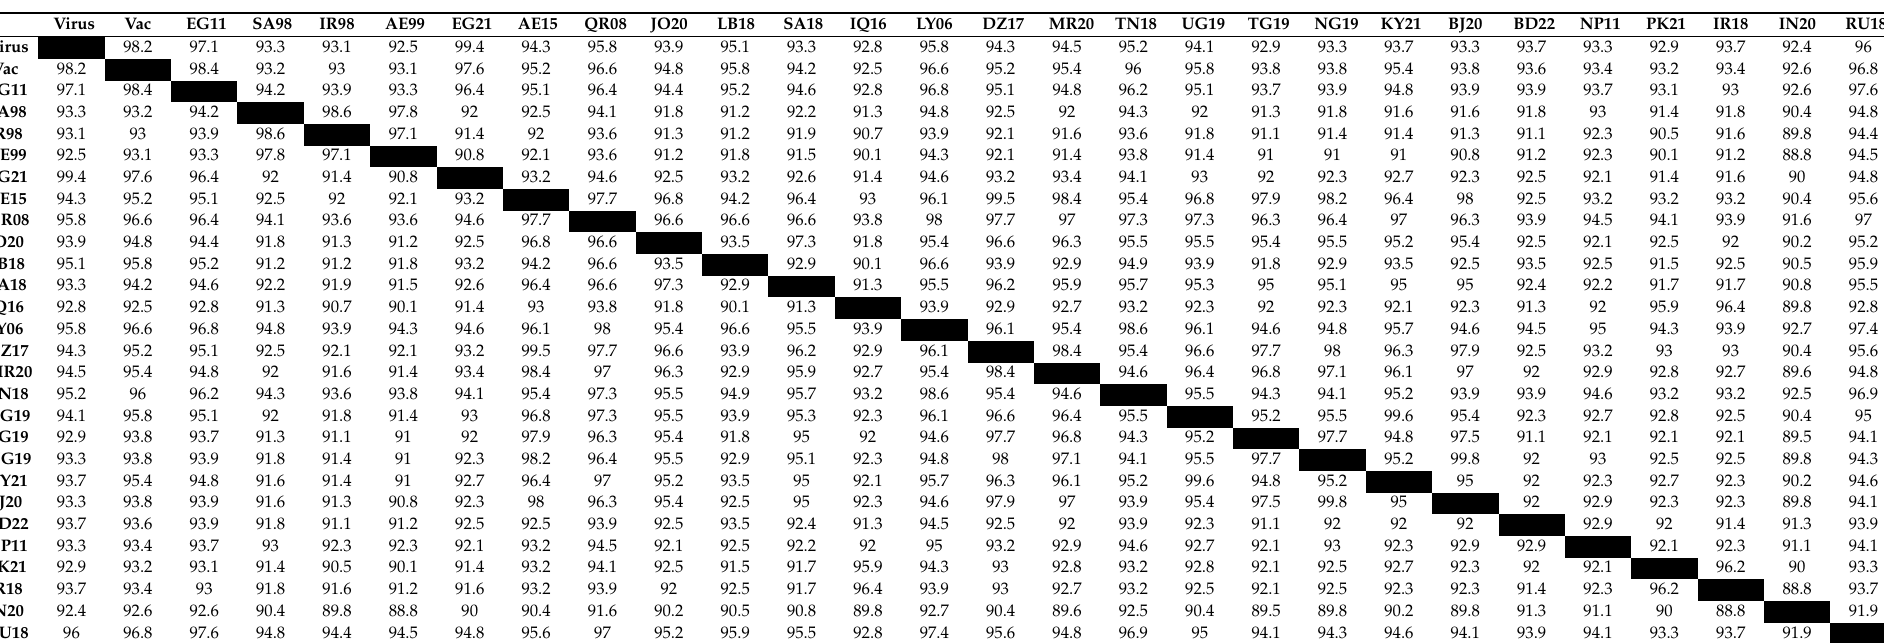
Table 4. Challenge virus hemagglutination gene amino acid similarity